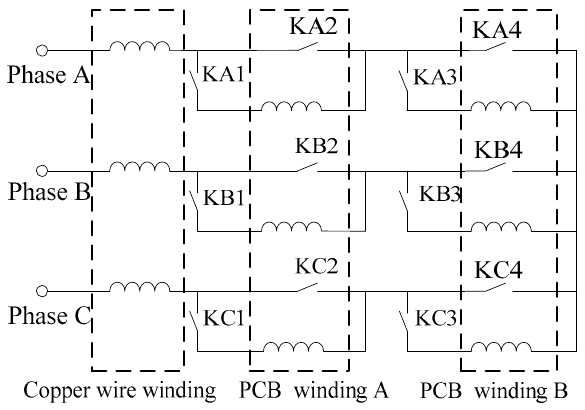
Figure 13. Circuit of the winding switch. Table 5. Switch state.